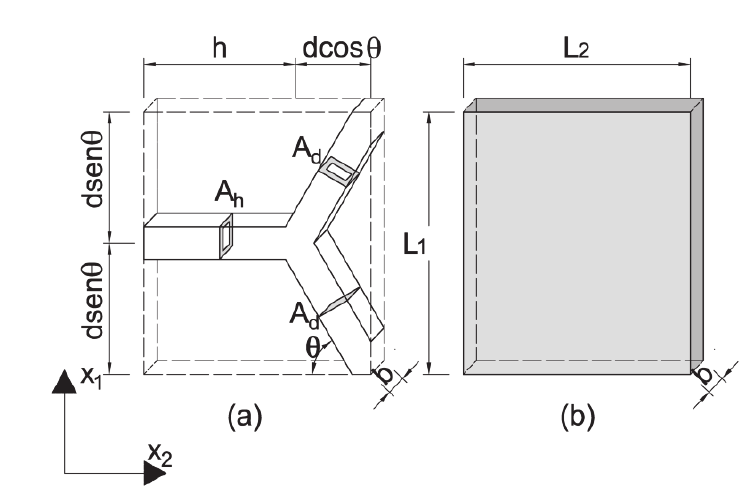
Figure 7: Hexagrid. Definition of the relative density for the unit